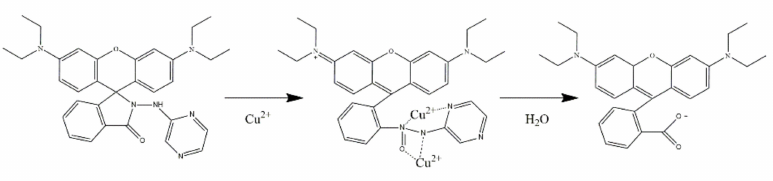
Figure 17. The proposed response mechanism of the prepared sensor (Table 1, No. 22) for Cu 2+ [53]. Yang L., et al. reported a novel rhodamine-based sensor, poly-NRG, modified by picolyl groups serving as the recognizing ligand for Cu 2+ (Table 1, No. 23) [54]. The prepared poly-NRG was further modified into gel balls for the Cu 2+ adsorption which showed a specific reaction in the presence of Cu 2+ with obvious color changes and achieved recycling after treatment with EDTA solution (Figure 18). Hu L., et al. reported a NIR fluorescent sensor EtRh-N-NH 2 employing rhodamine as a fluorescent core and a hydrazine group as a responsive site for Cu 2+ (Table 1, No. 24) [27]. The sensitivity and selectivity of the prepared sensor turned out to be satisfactory with the low detection limit (6 × 10 − 6 M). The proposed sensing mechanism was shown in Figure 19. Furthermore, EtRh-N-NH 2 was used in the bio-imaging of Cu 2+ in living